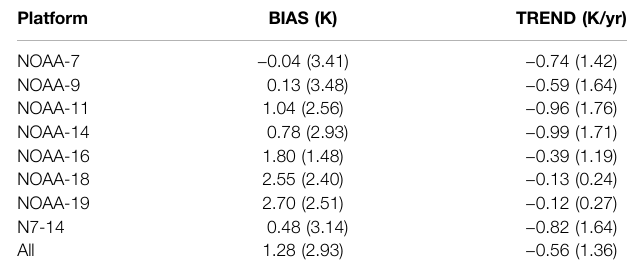
TABLE 6| Statistical assessment ofLiu etal.(2019)orbital driftcorrectionmethod for each NOAA platform, for NOAA-7 to 14 platforms, and overall: average value over all sites with its standard deviation in parentheses. TREND: the lineal trend of the difference between drifted and reference time